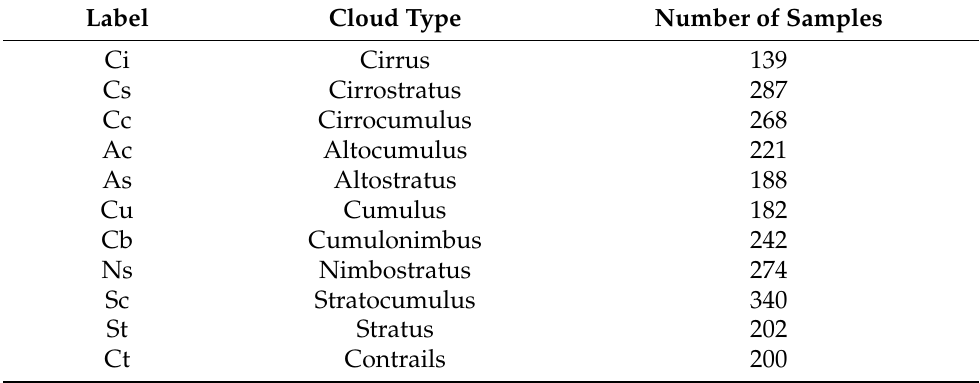
Table 4. Details of CCSN dataset.